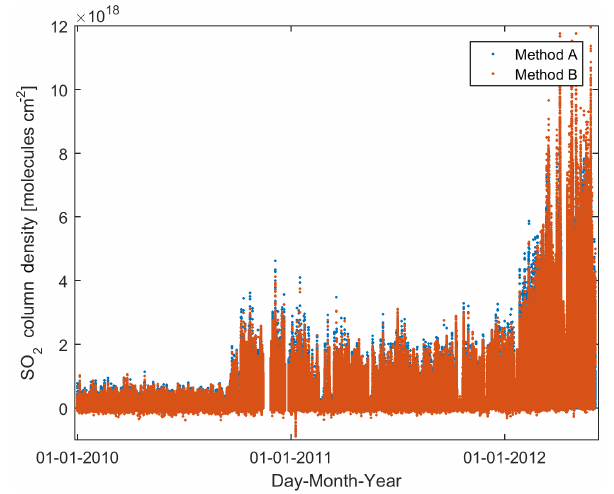
Figure B1. SO 2 CD time series for instrument D2J2200 at Nevado del Ruiz. The blue dots show a NOVAC-type evaluation while the red dots show the SO 2 CDs from a modelled FRS.